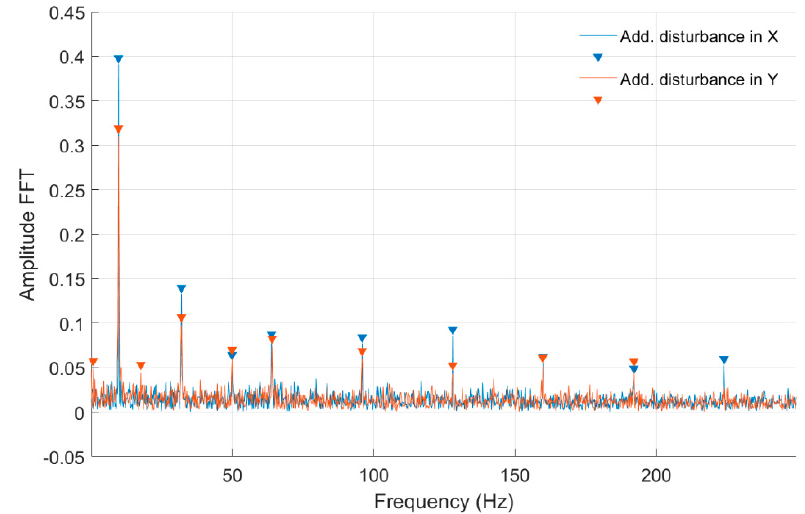
Figure 15. FFT of strain-level measurement for constant motor speed equal to 7 rev/s with disturbance from the control system for a quarter-bridge configuration (Node 955).